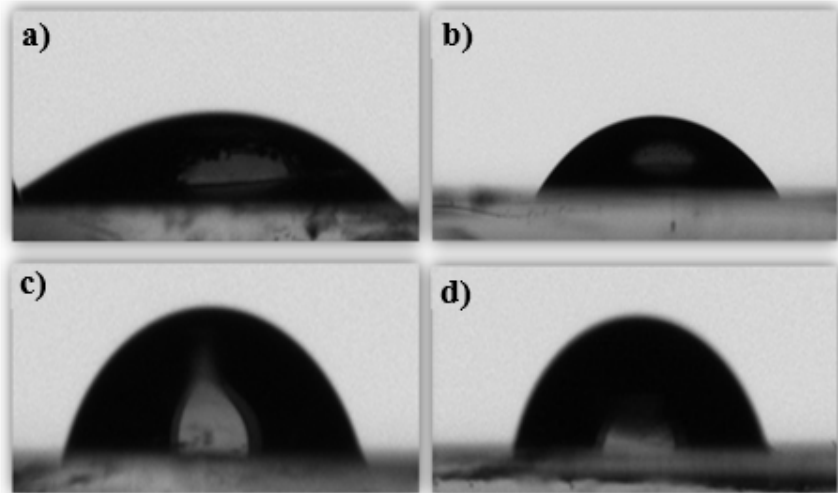
Figure 7 - Contact angle measurements on the surface of ITO modified AuNPs as a function of adsorption time of AuCl 4- . The contact angle for each sample were measured by dropping 2 µL of distilled water onto ITO and ITO modified surfaces before and after the adsorption of n-dodecanothiol. Static contact angle for a) ITO-PAmAm-(PSS/PAmAm) (PSS/PAmAm) modified with AuNPs at 5 min, c) 30 min and d) 120 minutes of adsorption. 2 Immersion time in n-dodecanothiol solution (20%): 5 hours.